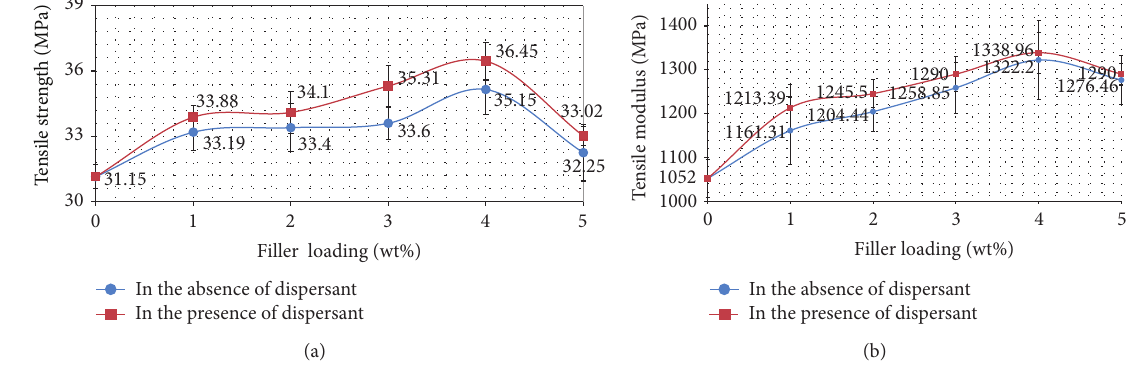
Figure 2: Tensile strength and tensile modulus of PP/nano 𝛼 -Al 2 O 3 composites at various loadings.